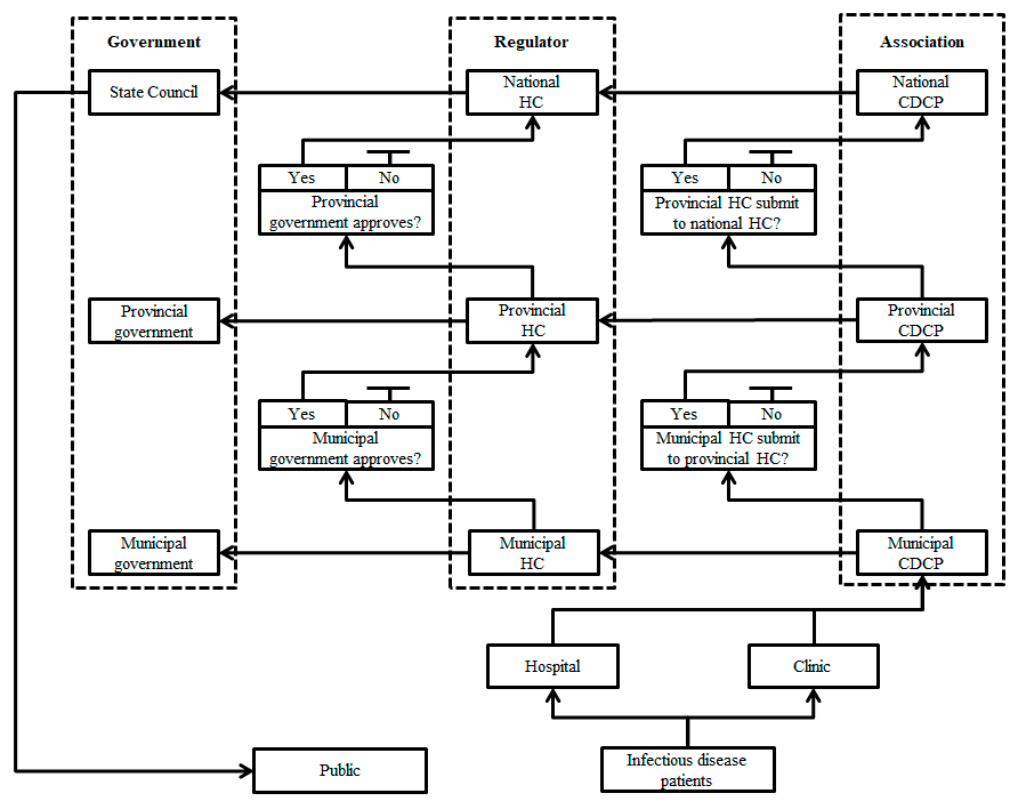
Figure 5. Information transmission path of China’s public health management system.